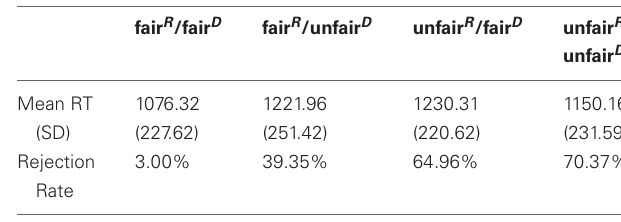
Table 1 | Behavioral results from the three-person ultimatum